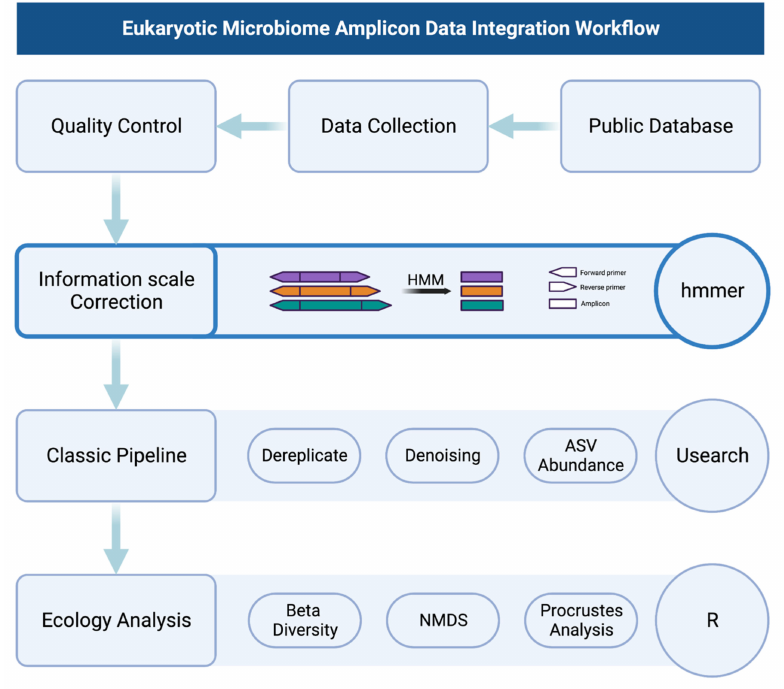
Figure 2. Eukaryotic microbiome amplicon data integration